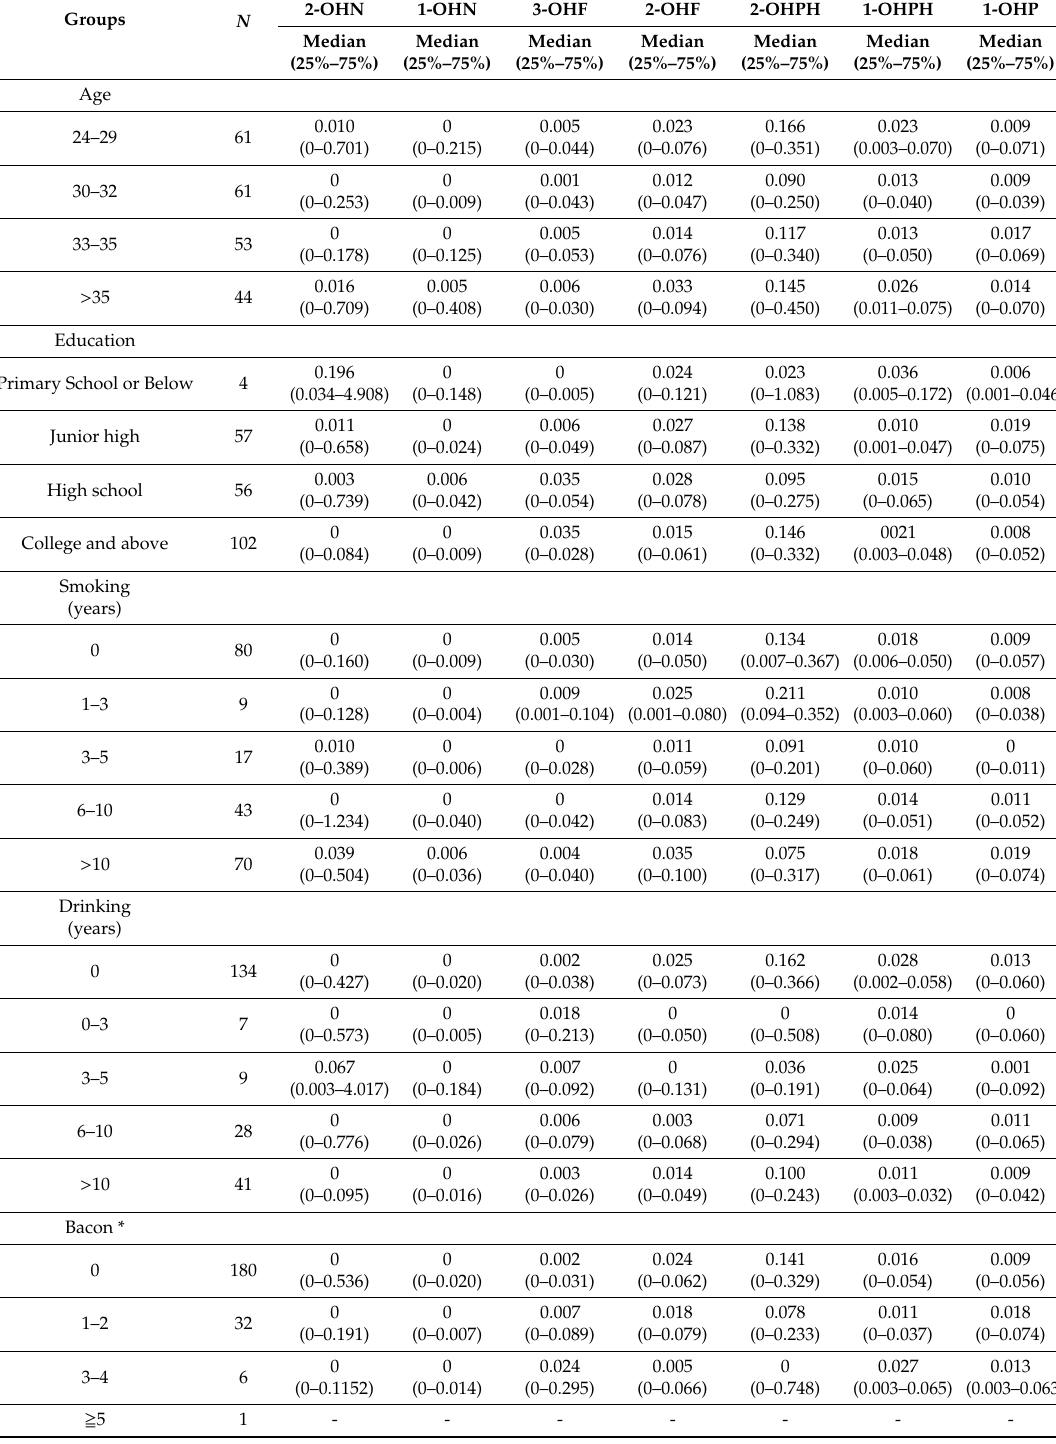
Table 2. Demographic characteristics of the participants and urinary PAHs level ( µ g /